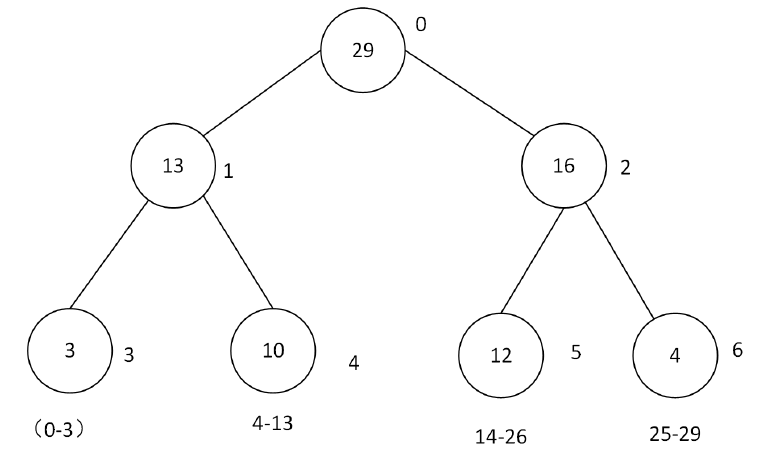
Figure 8. The schematic diagram of SumTree.